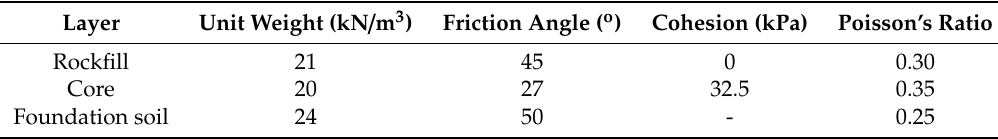
Figure 1. 2D finite element model of a baseline earth core rockfill dam (ECRD). Table 1. Properties of the dam and foundation soil.